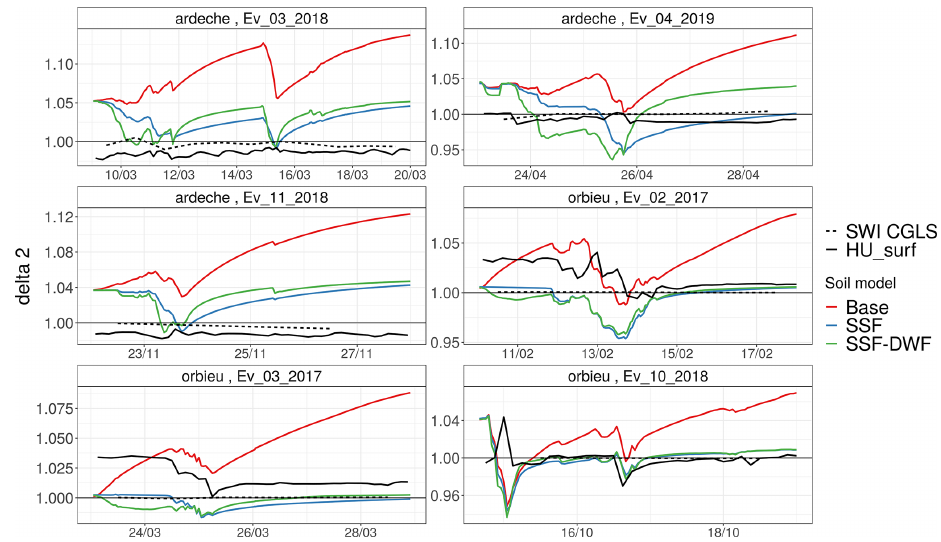
Figure 9. Time series of index δ 2 defined by Zoccatelli et al. (2011) for the six events, computed for the SSD outputs for the BM, SSF, and SSF–DWF models, and also for the LDAS-Monde HU surf variable and the CGLS SWI.